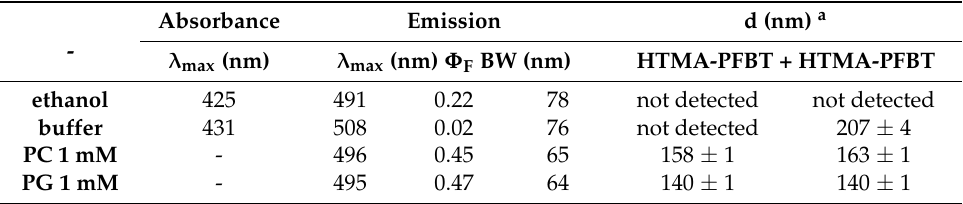
Table 1. Absorption, fluorescence characterization and hydrodynamic diameter of HTMA-PFBT in ethanol, buffer, Large Unilamelar Vesicles (LUVs) of phosphatidylglycerol (PG) and LUVs of phosphatidylcholine (PC).